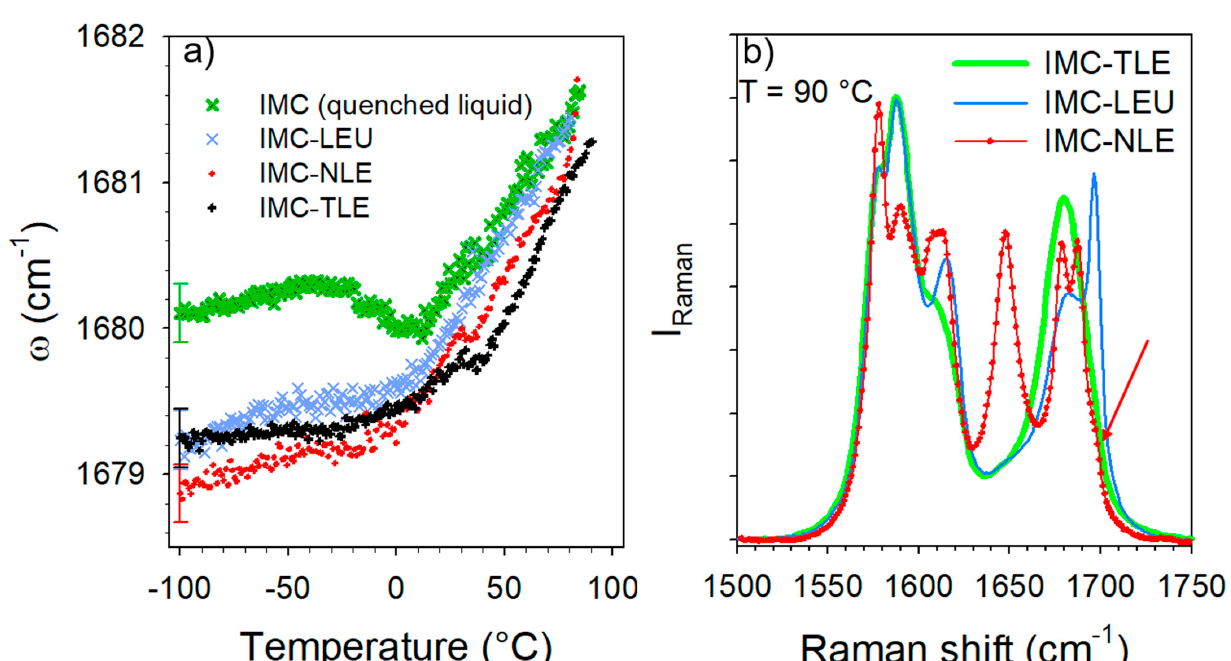
Figure 6 . Analysis of the C=O stretching region of the IMC–AA blends. ( a ) Temperature dependence of the band frequency distinctive of H-bonding — only one error bar was reported for better clarity. ( b ) Spectra of the IMC–AA blends collected at 90 °C. The red arrow showing the subtle shoulder reflecting a very weak proportion of the γ phase after recrystallization mostly in the α phase in the IMC–NLE.